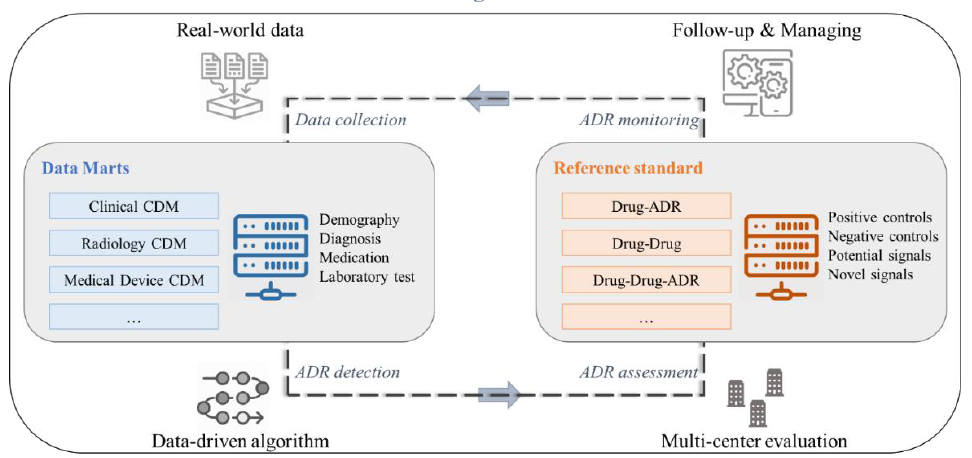
Figure 3. Feature diagram of the platform for active pharmacovigilance.